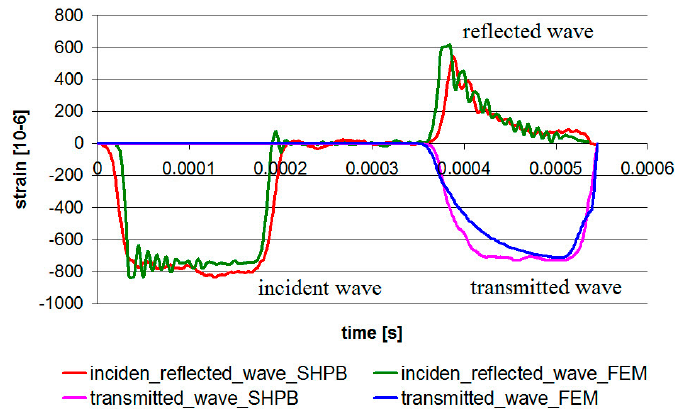
Figure 15. The comparison between numerical and laboratory results.